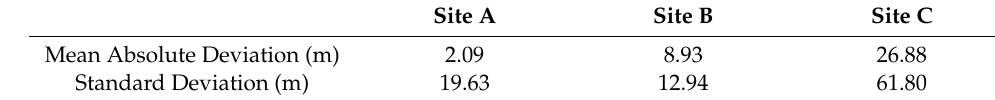
Table 5. Accuracy validation results using GF-1/ZY-3.